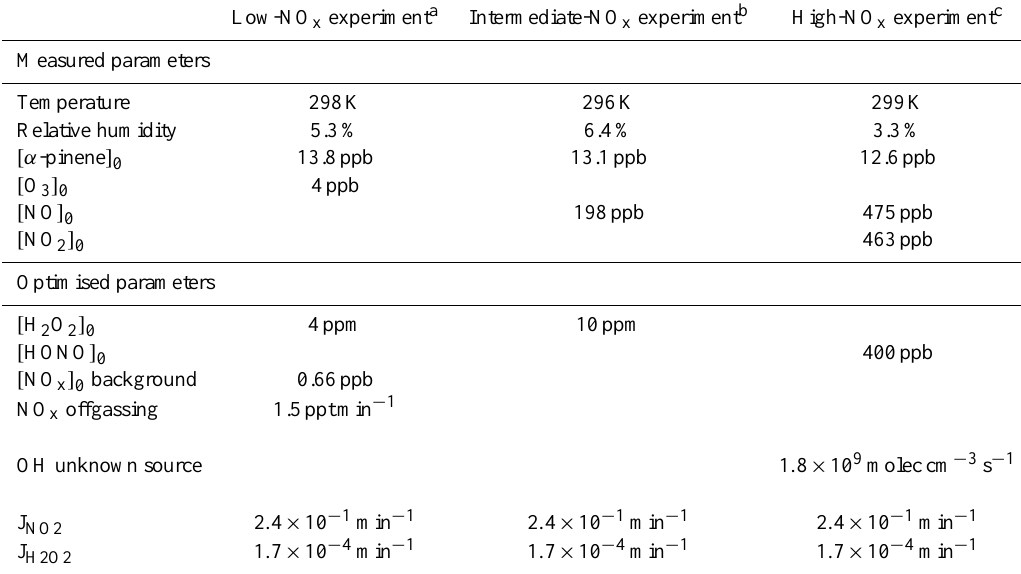
Table 3. Initial conditions used to simulate α -pinene oxidation experiments performed in the Caltech